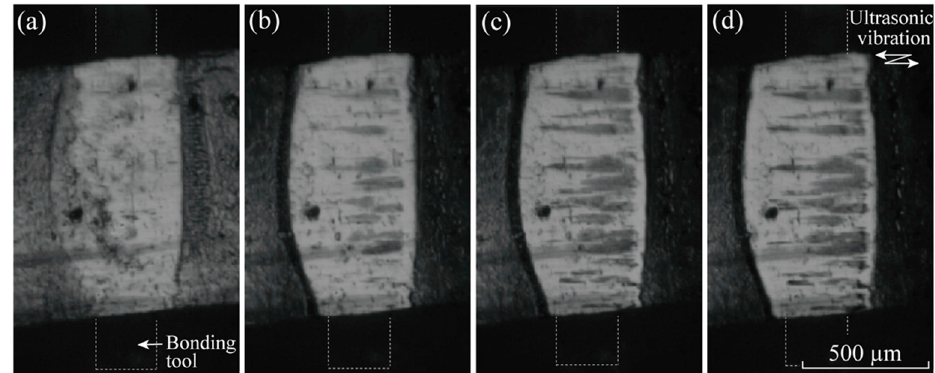
Figure 4. In-situ observation results (video captures) of the bonding interface between Al ribbon and silica substrate obtained at F rate = 10 4 fps. The bonding condition is F b = 7 N and P u = 3 W. Simultaneous measurement result of ultrasonic vibration amplitude is shown in Figure 3 (a–1): ( a ) t = 3 ms; ( b ) t = 50 ms; ( c ) t = 100 ms; ( d ) t = 400 ms.